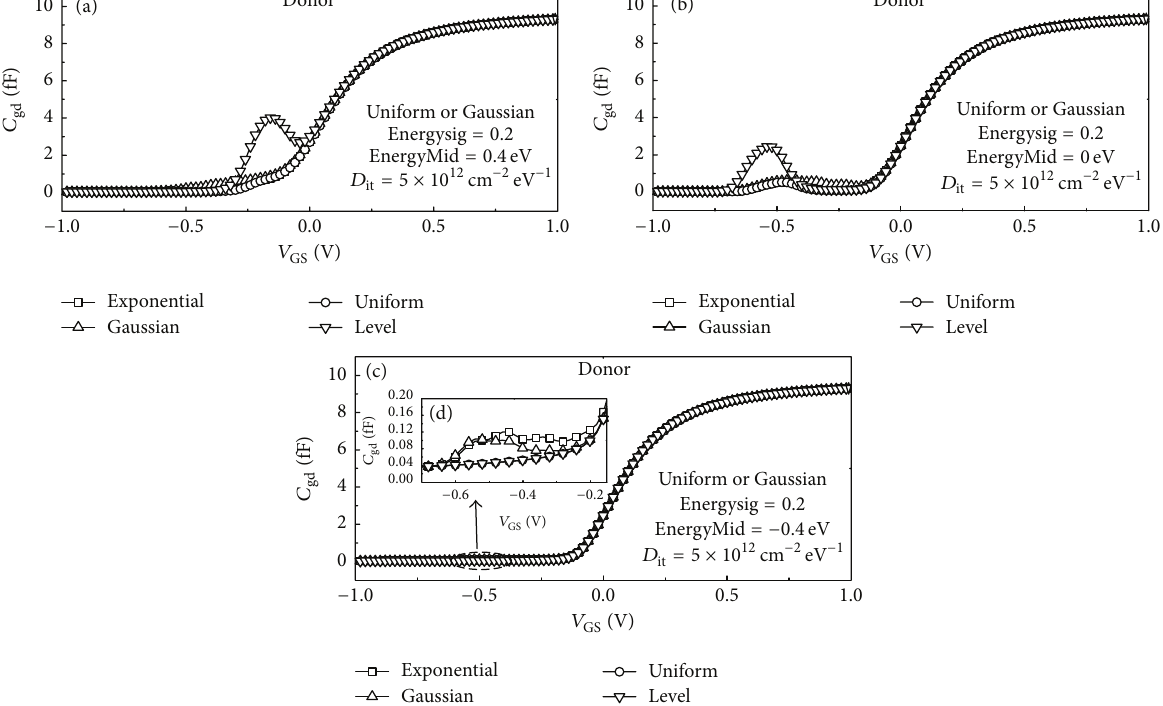
Figure 18: Four types of energetic distribution for donor-type are located at three representative level positions which are (a) EnergyMid = 0.4 eV ( 𝐸 𝑖 + 0.4 eV), (b) EnergyMid = 0.0 eV, and (c) EnergyMid = 0.4 eV,